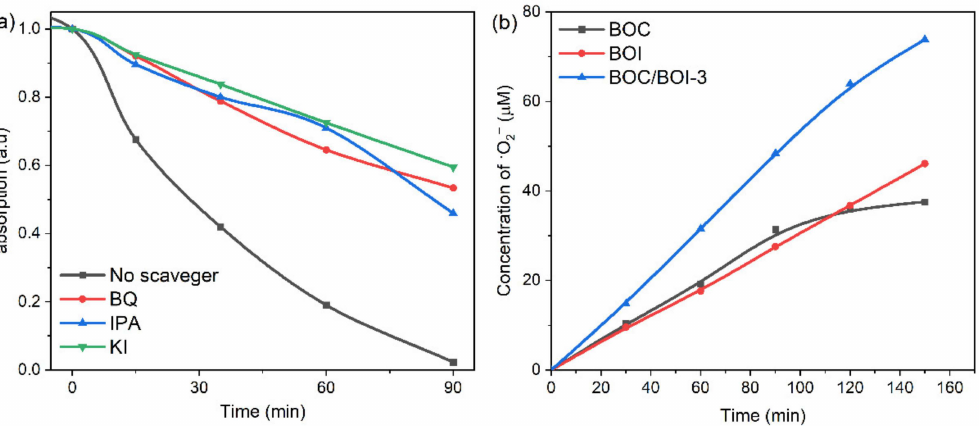
Figure 6. ( a ) Radical trapping experiments during degradation of RhB over BOC/BOI-3, ( b ) time- dependent concentration plots of the amount of • O 2 −